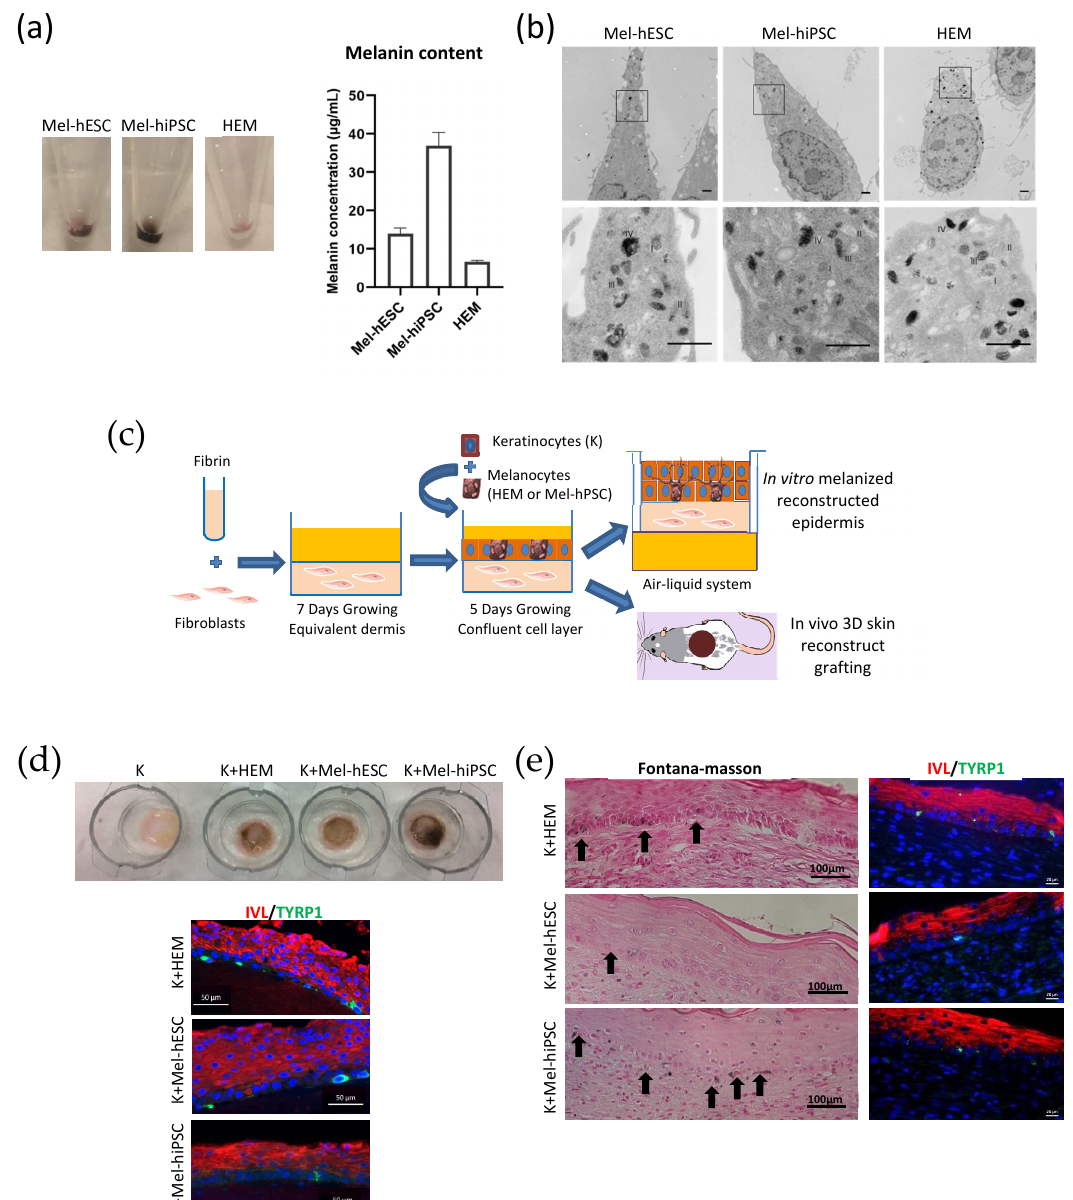
Figure 2. Functionality of hPSC-derived melanocytes. ( a ) (left) Cell pellet pictures of Mel-hESC, Mel-hiPSC at passage 7, and HEMs. (right) Melanin content measurement in Mel-hESC, Mel-hiPSC, and HEMs. Each value represents the mean of three independent experiments. ( b ) Representative elec- tronic microscopy images of melanosome stages in Mel-hESC, Mel-hiPSC, and HEMs. Characteristic immature unpigmented (stages I/II) and mature pigmented (stages III/IV) melanosomes are